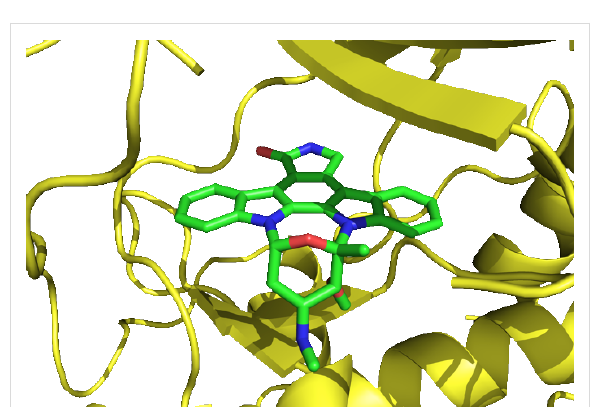
DNA-cleavable complex they prevent the replication of DNA and act as efficient antitumor compounds